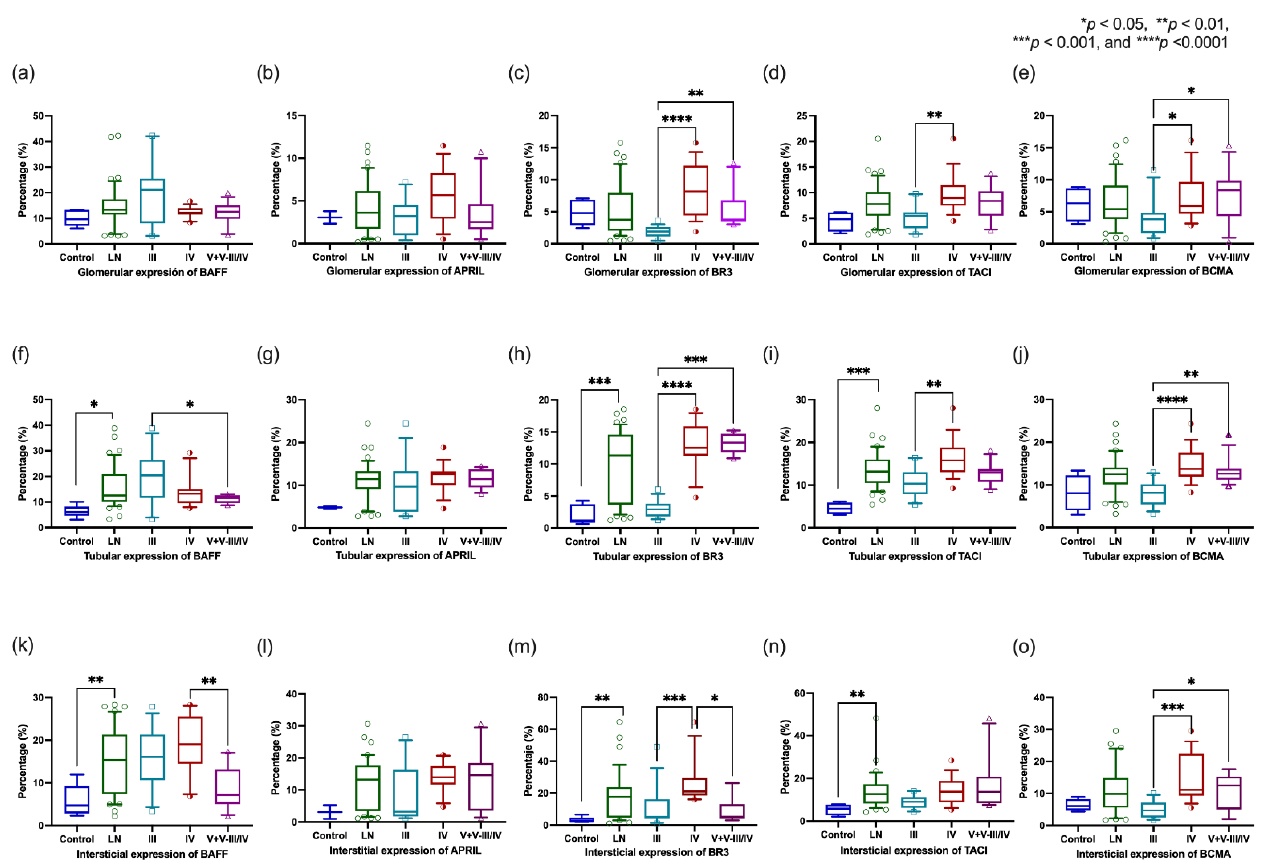
Figure 3. Association of BAFF system expression and proliferative LN classes according to glomerular, tubular, and interstitial zones. Glomerular expression of BR3 and BCMA was higher in class IV and V+V-III/IV groups than in class III; TACI showed a higher expression in class IV compared to class III ( c – e ). The tubular expression of BAFF was higher in the LN group, mainly in class III ( f ). The proliferative lesions (class IV) showed a higher expression of BR3, TACI, and BCMA ( h – j ). Compared to the interstitial BAFF system expression, BAFF, BR3, and TACI displayed higher expressions than the kidney controls ( k ). The Class IV group had higher expressions of BAFF, BR3, and BCMA ( k , m , o ). ( a , b , g , l , n ) did not show a statistical difference ( p > 0.05). The p -value was obtained through Kruskal – Wallis and post hoc tests. Data are shown as median with IQR. BAFF: B-cells activating factor, APRIL: A proliferation-inducing ligand, BR3: BAFF receptor, TACI: Transmembrane activator and CALM interactor, BCMA: B-cell maturation antigen. IQR: Interquartile range, LN: lupus nephritis.